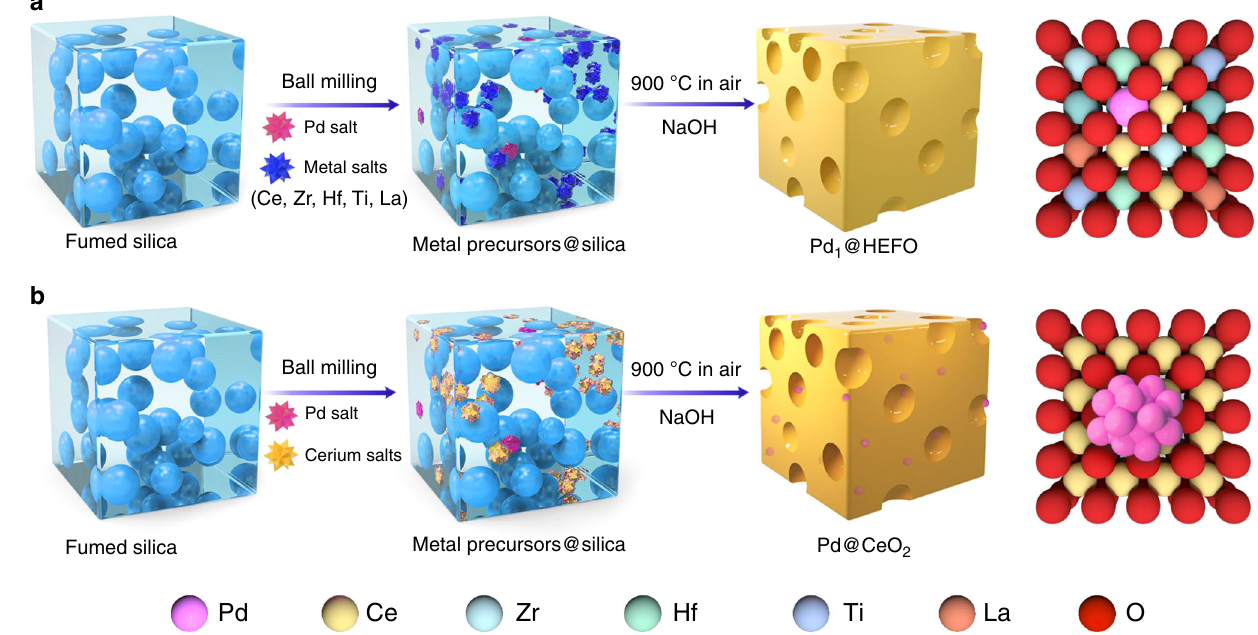
Fig. 1 Schematic illustration of mechanochemical-assisted route for the synthesis of serial catalysts. a Pd 1 @HEFO, showing the possible high dispersion of a small portion of Pd single atoms on the surface of HEFO support and incorporation of a large portion of Pd single atoms into HEFO sublattice after calcination at 900 °C. b Pd@CeO 2 , showing the aggregation of Pd clusters predominantly located on the surface of CeO 2